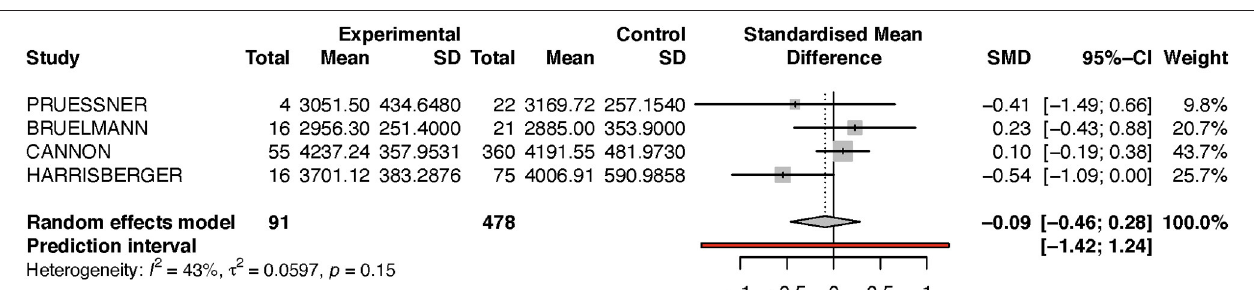
FIGURE 4 | Forest plot for Left hippocampus (full analysis).